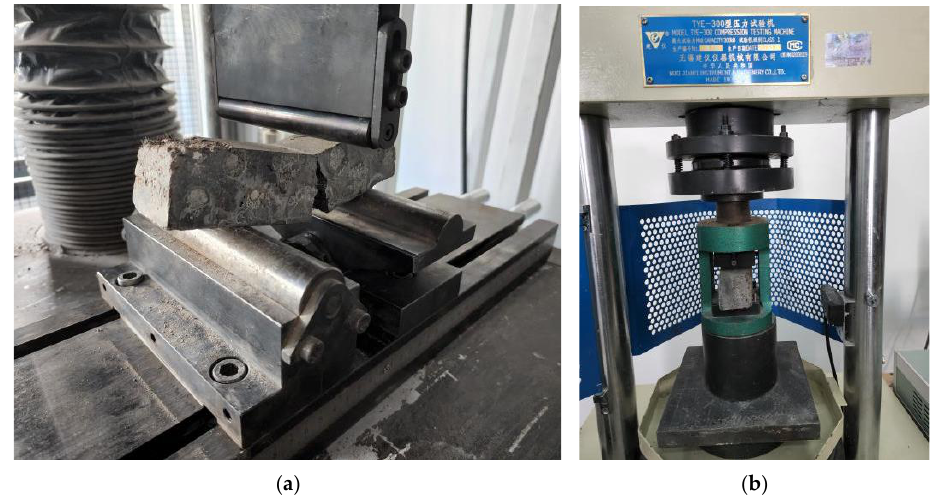
Figure 4. UHPC-GJL test block material property test. ( a ) Breaking test; ( b ) compression test. Table 3. UHPC-GJL material performance parameters.